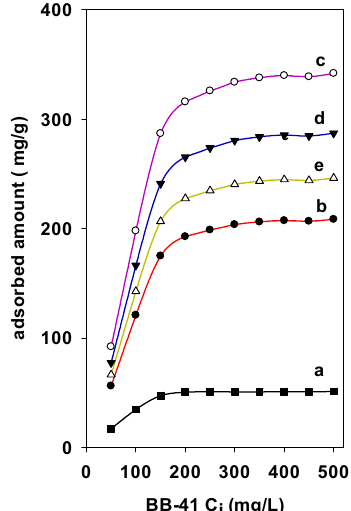
Figure 6. Effect of Zr contents in the Zr(X) ‐ PCH materials on the adsorbed amounts of BB ‐ 41 dye. (a) Zr(0) ‐ PCH, (b) Zr(3) ‐ PCH, (c) Zr(6) ‐ PCH, (d) Zr(12) ‐ PCH, and (e) Zr(24) ‐ PCH.